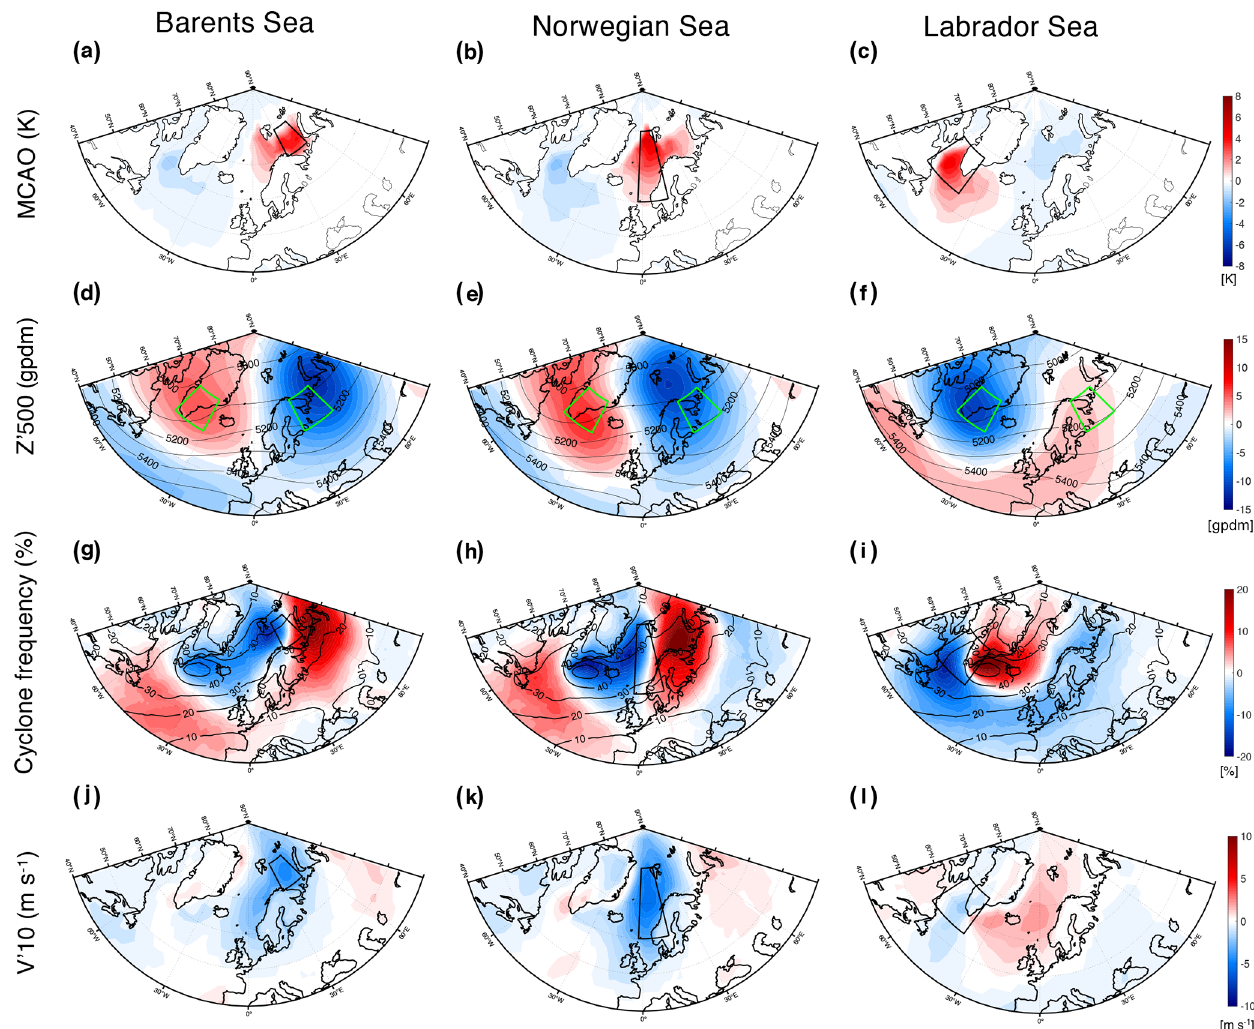
Figure 2. Regional flow patterns during periods of moderate-to-strong MCAO index ( M ≥ 4K) during DJFM over (a, d, g, j) the Barents Sea, (b, e, h, k) the Norwegian Sea and (c, f, i, l) the Labrador Sea regions. Composites of daily averages of (a–c) MCAO index anomaly (colour shading, in K), (d–f) geopotential height anomaly at 500hPa (shading, in gpdm) and mean 500hPa geopotential height (black contours, in intervals of 100gpm) for DJFM in climatology. (g–i) Cyclone frequency anomaly (shading). The winter (DJFM) climatology of cyclone frequency is shown by black contours (starting at 10%, in intervals of 10%). (j–l) The 10m meridional wind anomaly (shading, in ms − 1 ). Black boxes show the relevant region of interest: the Barents Sea, the Norwegian Sea and the Labrador Sea. Green boxes in (d–f) show the areas used in the calculation of the zonal dipole index (see Sect. 2.3). Only statistically significant values above the 95% level are shown by the shading (based on a two-sided Student’s t